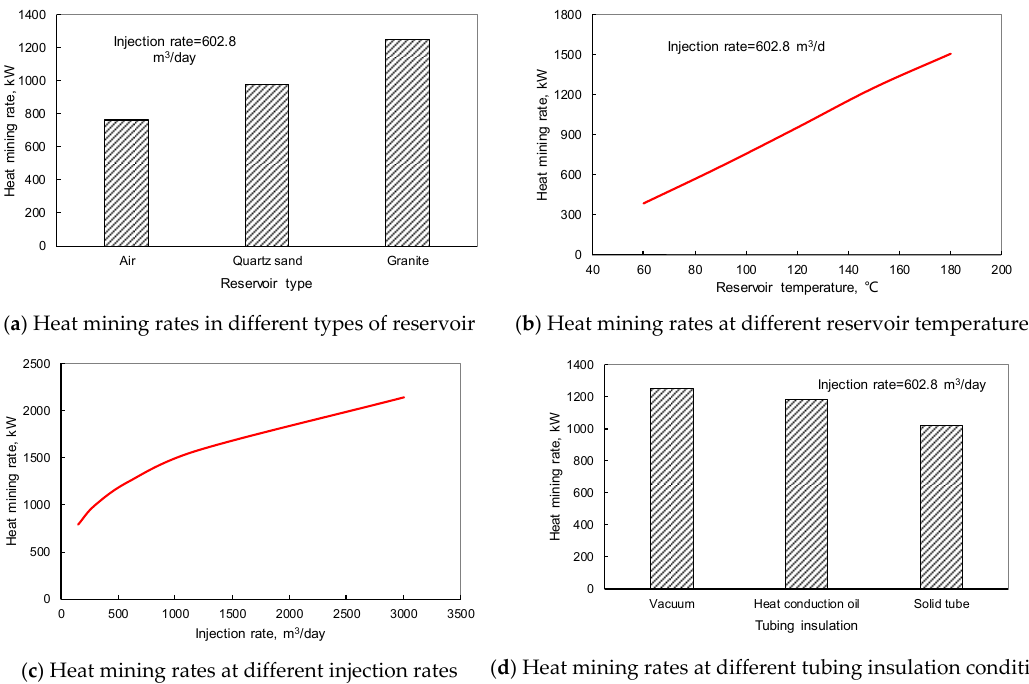
Figure 19. The calculated heat mining rate of water in a 2000 m horizontal well section at different conditions.